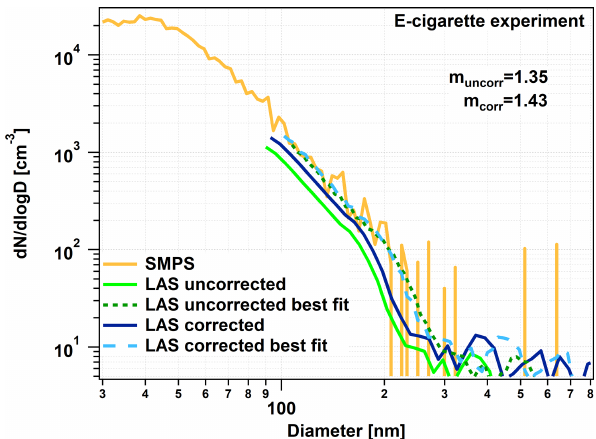
Figure 3. The e-cigarette experiment, showing the validation of our LAS correction. The orange line shows the measured SMPS number size distribution, the green lines the uncorrected LAS number size distribution (light: original; dark and dashed: best fit with m uncorr calculated RI), and the blue lines (dark: original; light and dashed: best fit with m corr calculated RI) are the loss-corrected LAS number size